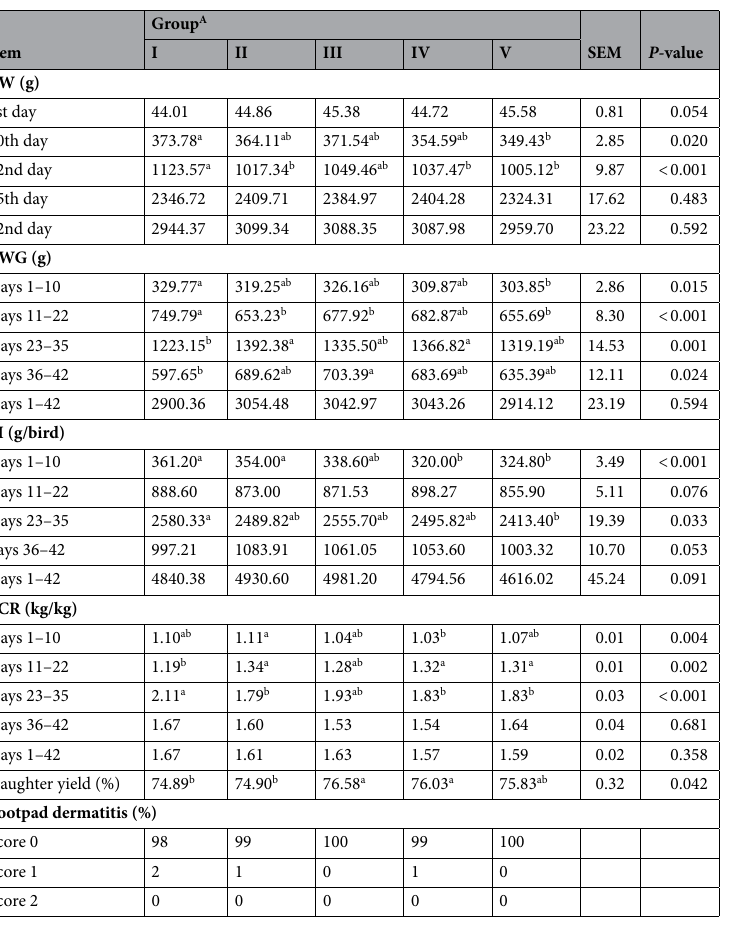
Table 2. Growth performance of broiler chickens. BW body weight, BWG bodyweight gain, FI feed intake, FCR feed conversion ratio, SEM standard error of the mean. a,b Values with different letters in a row differ significantly, P < 0.05. A Groups II, III, IV, V were fed with halloysite and zeolite (1:3 ratio) at 0,5% (1–35 days) and 1% (36–42 days) level. Aluminosilicates were also used for the litter: II—500 g of halloysite/m 2 ; III—250 g of halloysite/m 2 and 250 g of zeolite/m 2 ; IV—500 g of zeolite/m 2 ; V—130 g of halloysite/m 2 , 370 g zeolite/m 2